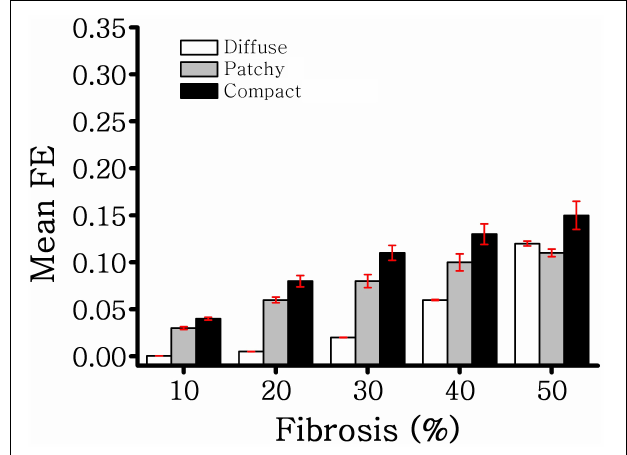
FIGURE 3 | Mean fibrosis entropy of diffuse, compact, and patchy